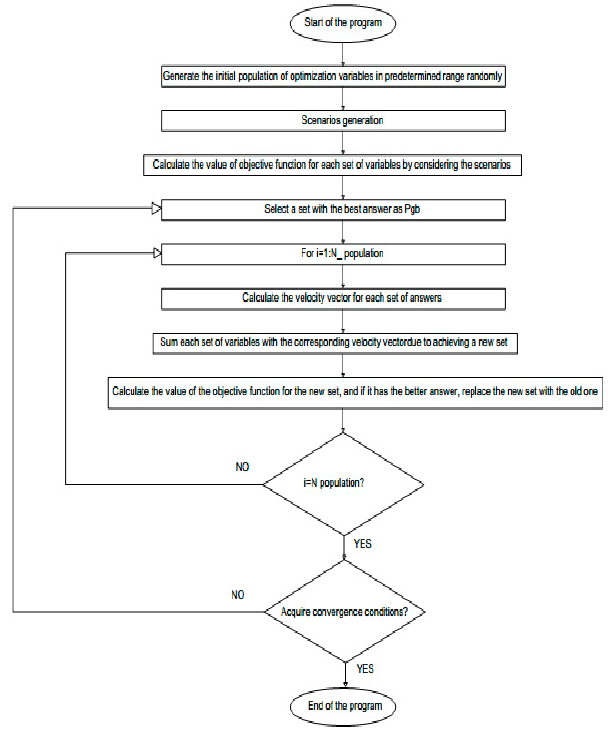
Figure 1. The flowchart of the problem solution.